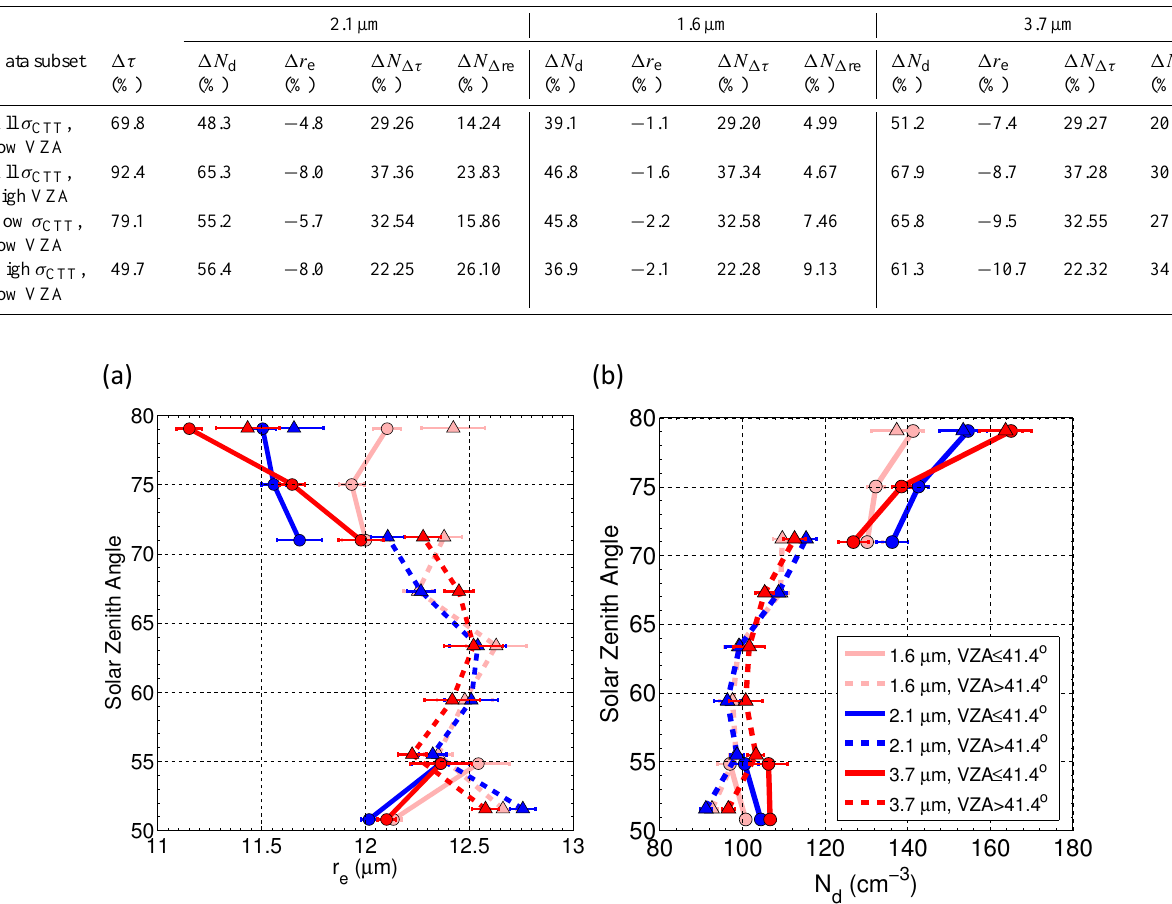
Figure 7. As for Fig. 5 except for the mean effective radius (a) and droplet concentration (b) for the different MODIS bands. wavelength is 2.1 µm and r e errors are only available for this band. Therefore, the percentage errors for this wavelength are applied as errors for the other wavelengths to give an es- timate of the expected